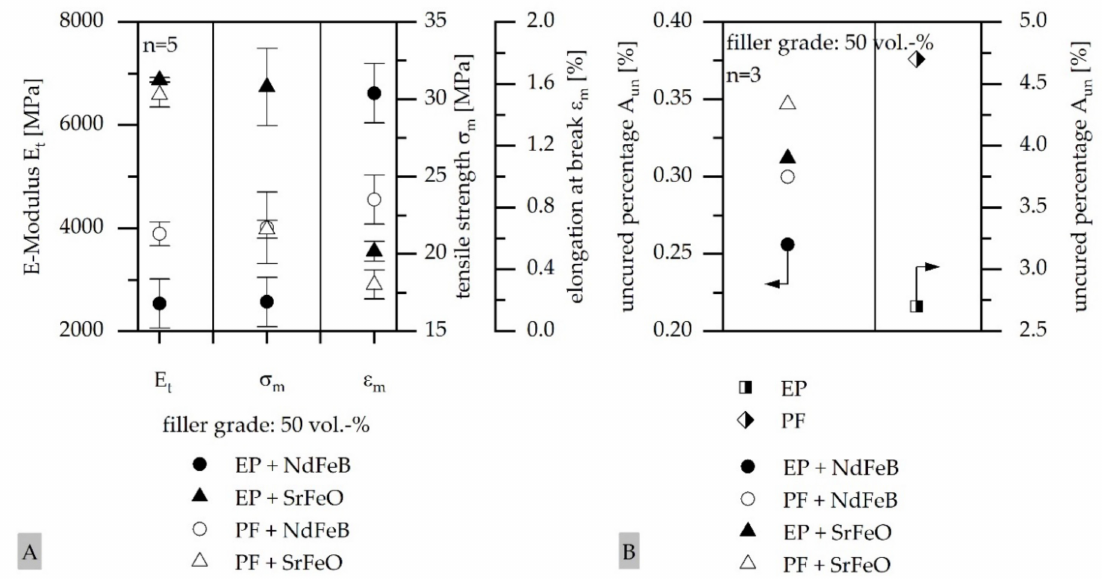
Figure 9. Mechanical properties ( A ) and uncured percentage A un ( B ) relative to different matrix materials and fillers (SrFeO: strontium-ferrite-oxide; NdFeB: neodymium-iron-boron; PF: phenolic resin; EP: epoxy